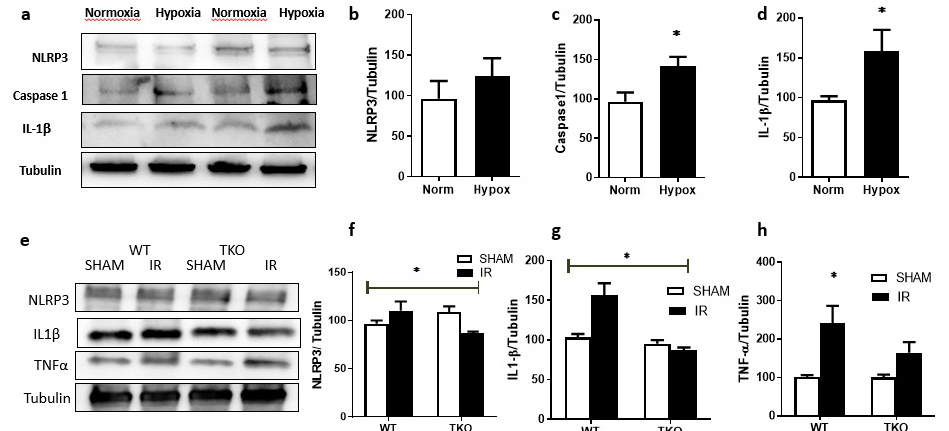
Figure 4. Primary Muller cells isolated from wildtype mice were exposed to hypoxia for 1hour followed by reperfusion in normoxia for 24-hours. ( a ) Representative of Western blot analysis and Statistical analysis showed no significant difference in NLRP3 expression ( b ), significant increase in Caspase-1 ( c ), and IL-1 (d) (* p < 0.05 vs normoxia, N = 4–6). ( d ) Representative of Western Blot